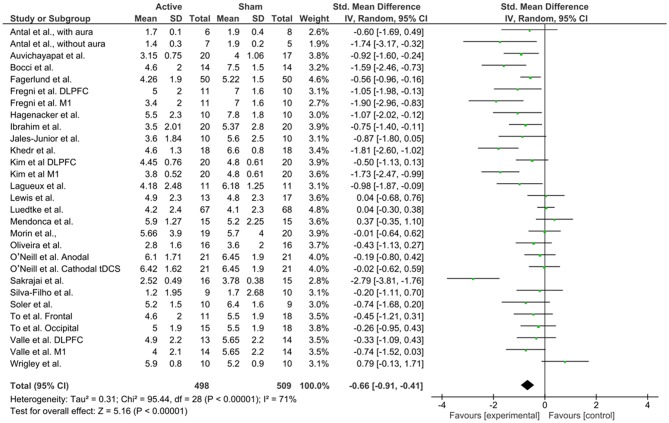
Forest plot of the effects of tDCS on pain levels for all studies reviewed (n = 23).